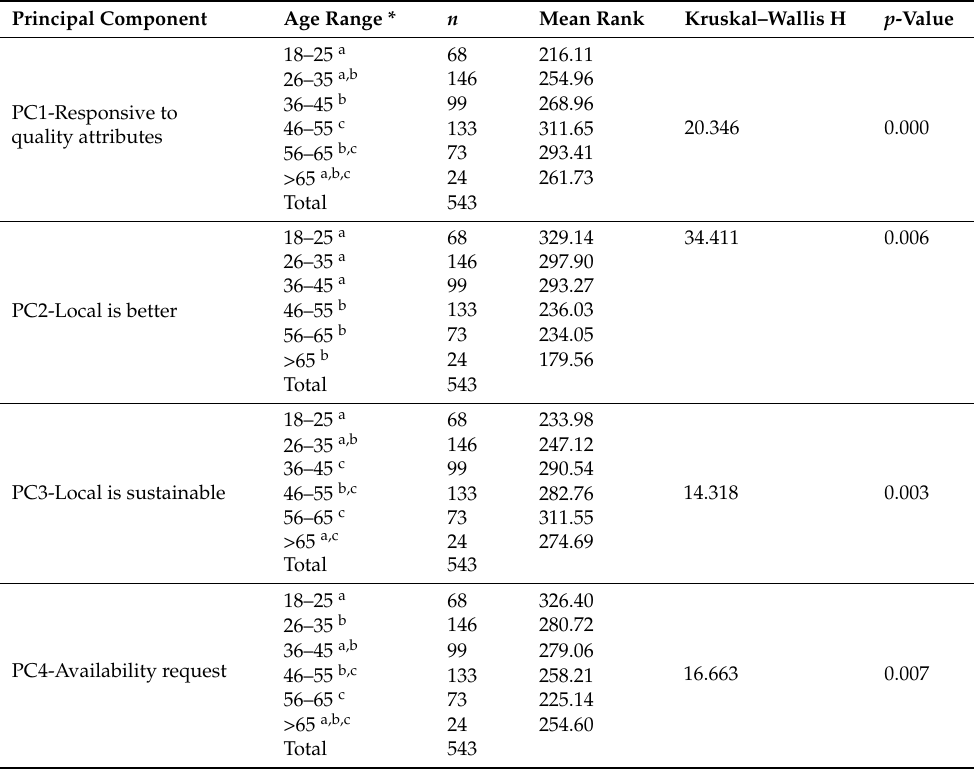
Table 4. Effect of age on the principal components’